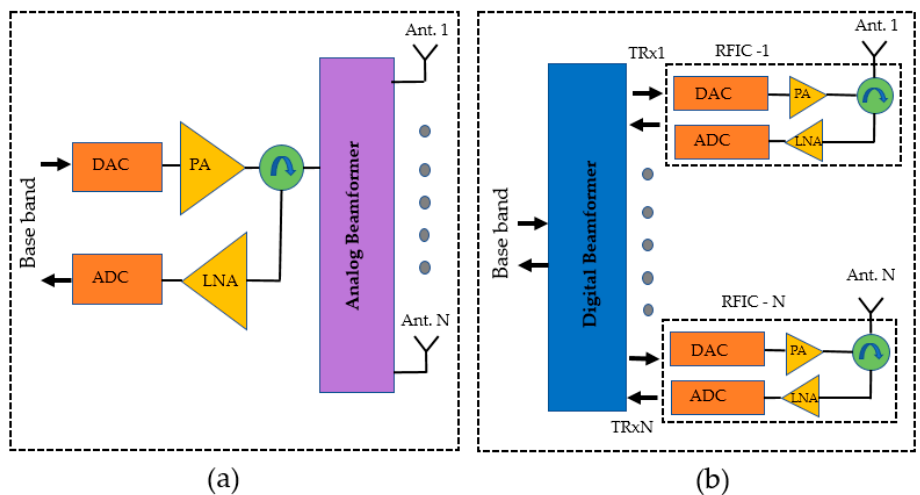
Figure 5. ( a ) Analog beamforming architecture; ( b ) digital beamforming architecture.